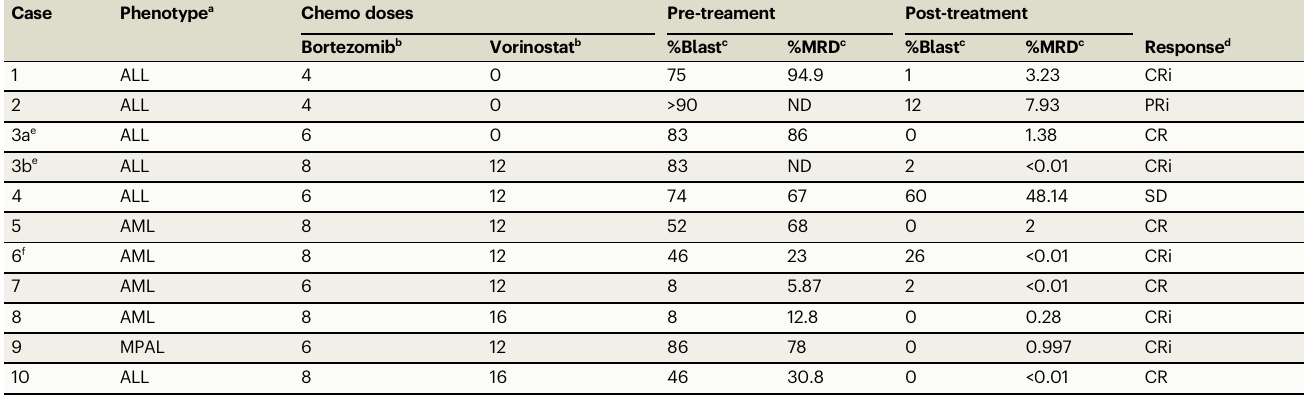
Table 2 | Clinical responses to bortezomib and vorinostat containing salvage regimens Case Phenotype